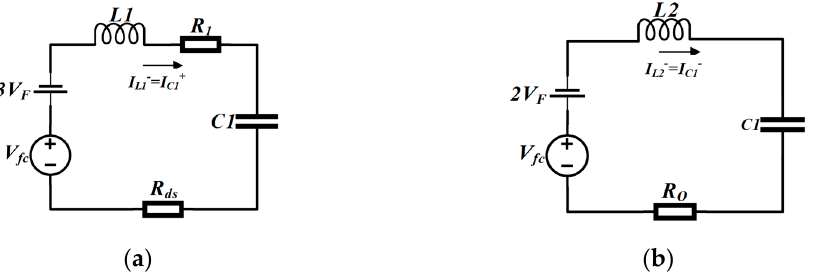
Figure 3. The equivalent circuit for capacitor charging and discharging: ( a ) charging circuit; ( b ) discharging circuit.